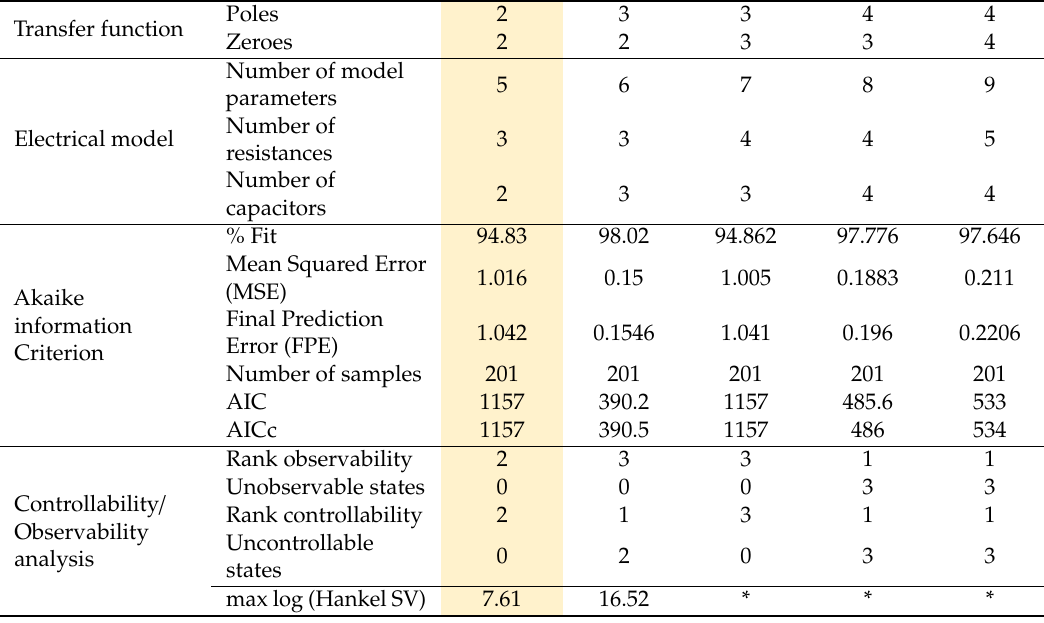
Table 3. Summary of model estimation for Metamizole Sodium.